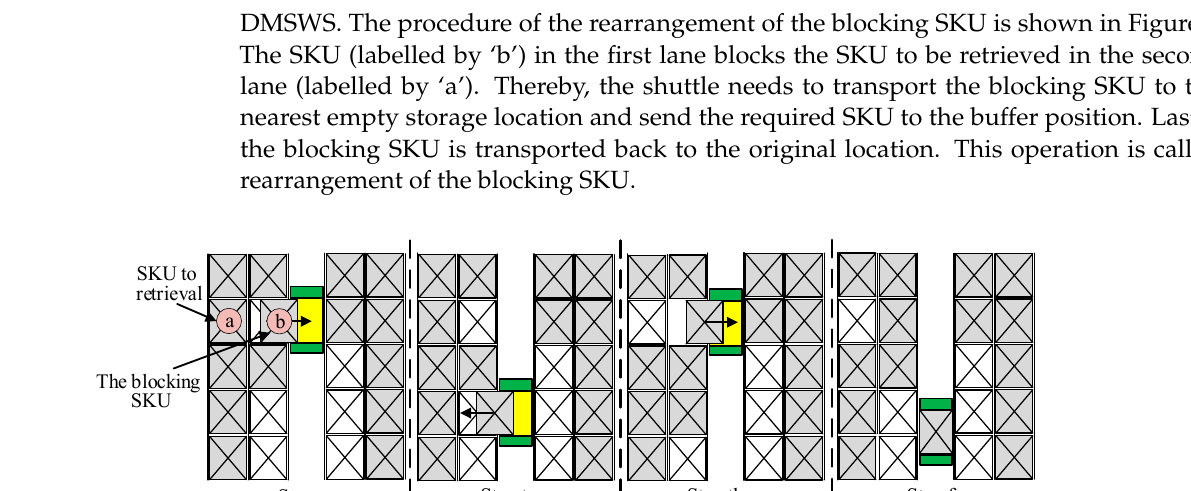
Figure 1. Schematic diagram of the double-deep multi-tier shuttle warehousing system. According to the structure of a double-deep SR, it has a higher space utilization than a single-deep SR. However, rearrangement operations will increase the retrieval task time, thereby reducing the system efficiency. According to the introduction of the FEM 9.851